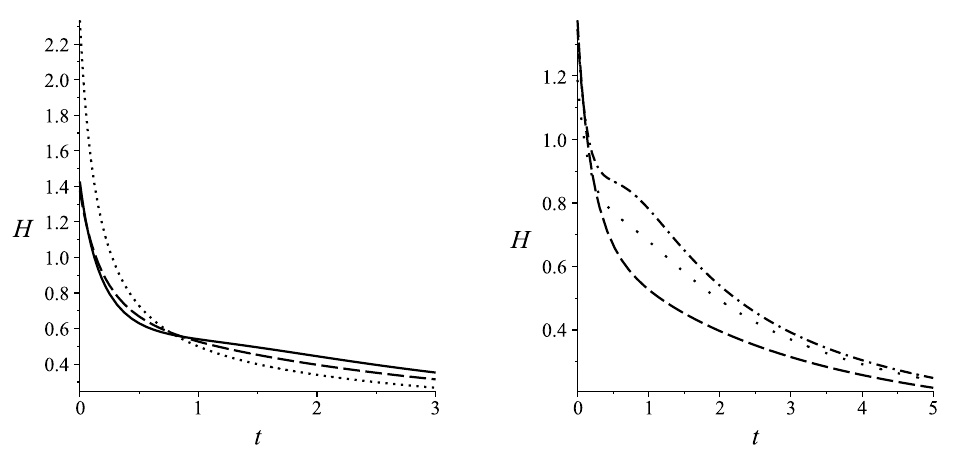
Figure 9 . The Hubble parameters H ( t ) for the same values of the constants as in (cid:12)gure 5. cosmological constant. Or it may indicate that this class of models has to be considered only in a (cid:12)nite time-range, assuming that at later times a di(cid:11)erent e(cid:11)ective description (for example, containing new (cid:12)elds) would become more